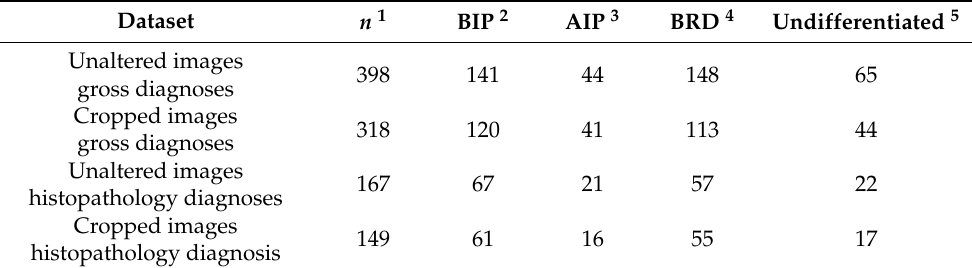
Table 1. Descriptive table of label distribution per group of images used to create image classification models, from deceased feedlot cattle right lateral lung